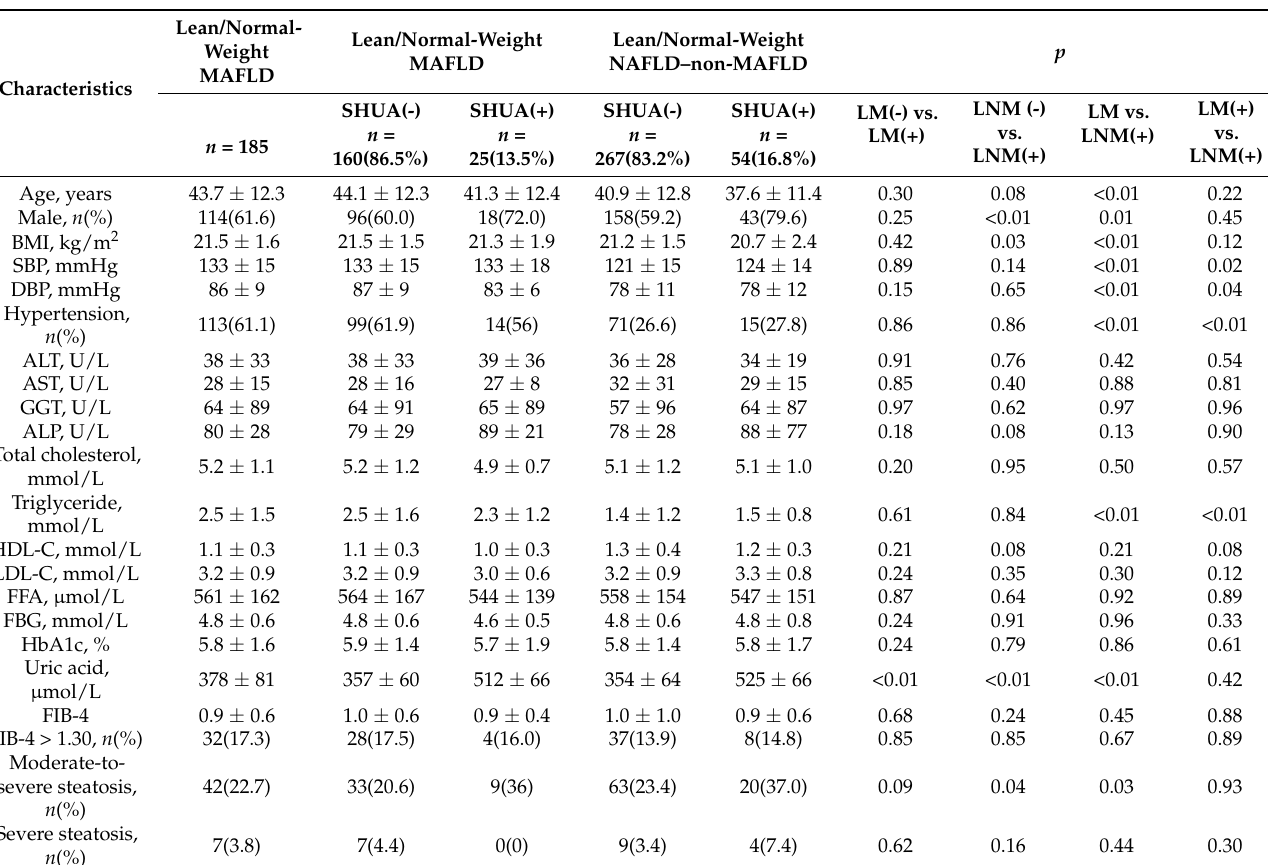
Table 3. Comparisons among lean/normal-weight MAFLD and lean/normal-weight NAFLD–non- MAFLD with SHUA in patients with